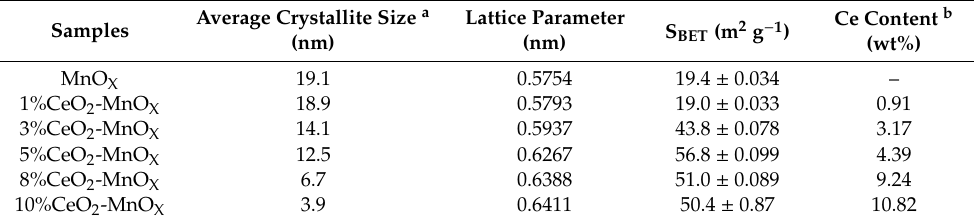
Table 2. Textural parameters of w CeO 2 –MnO X